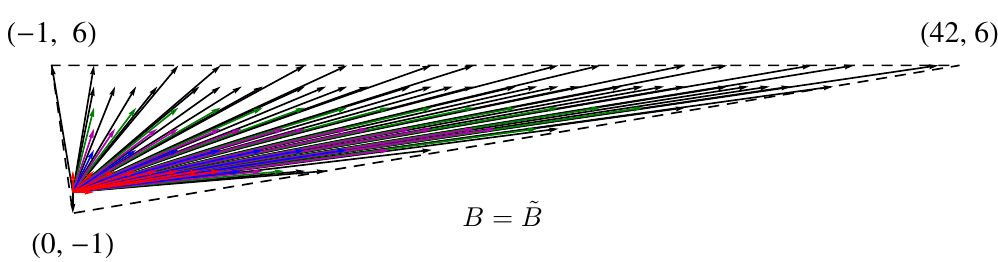
Figure 3 . The base B = ~ B over which the generic elliptic (cid:12)bration is the self-mirror Calabi-Yau threefold with Hodge numbers (251 ; 251). Note that the inner product between each pair of vertices is (cid:0) 6, so that B = ~ B (cid:24) (cid:0) 6 K B . Rays that are red, blue, purple, green correspond to curves in the toric base ~ B that carry non-Higgsable E 8 ; F 4 ; G 2 , and SU(2) gauge groups respectively. between each pair of these vertices is (cid:0) 6, the procedure of constructing the mirror base ~ B from monomials in O ( (cid:0) 6 K ) gives B = ~ B . The primitive rays in this base ((cid:12)gure 3) B